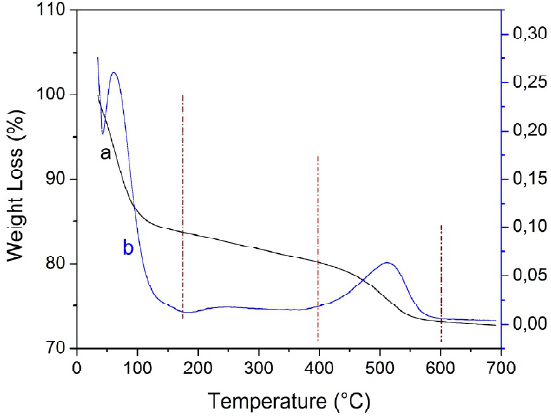
Fig. 4. (a) Thermogram and (b) thermogram derived of the SiO -Mag-IBU (1:16) sample 2